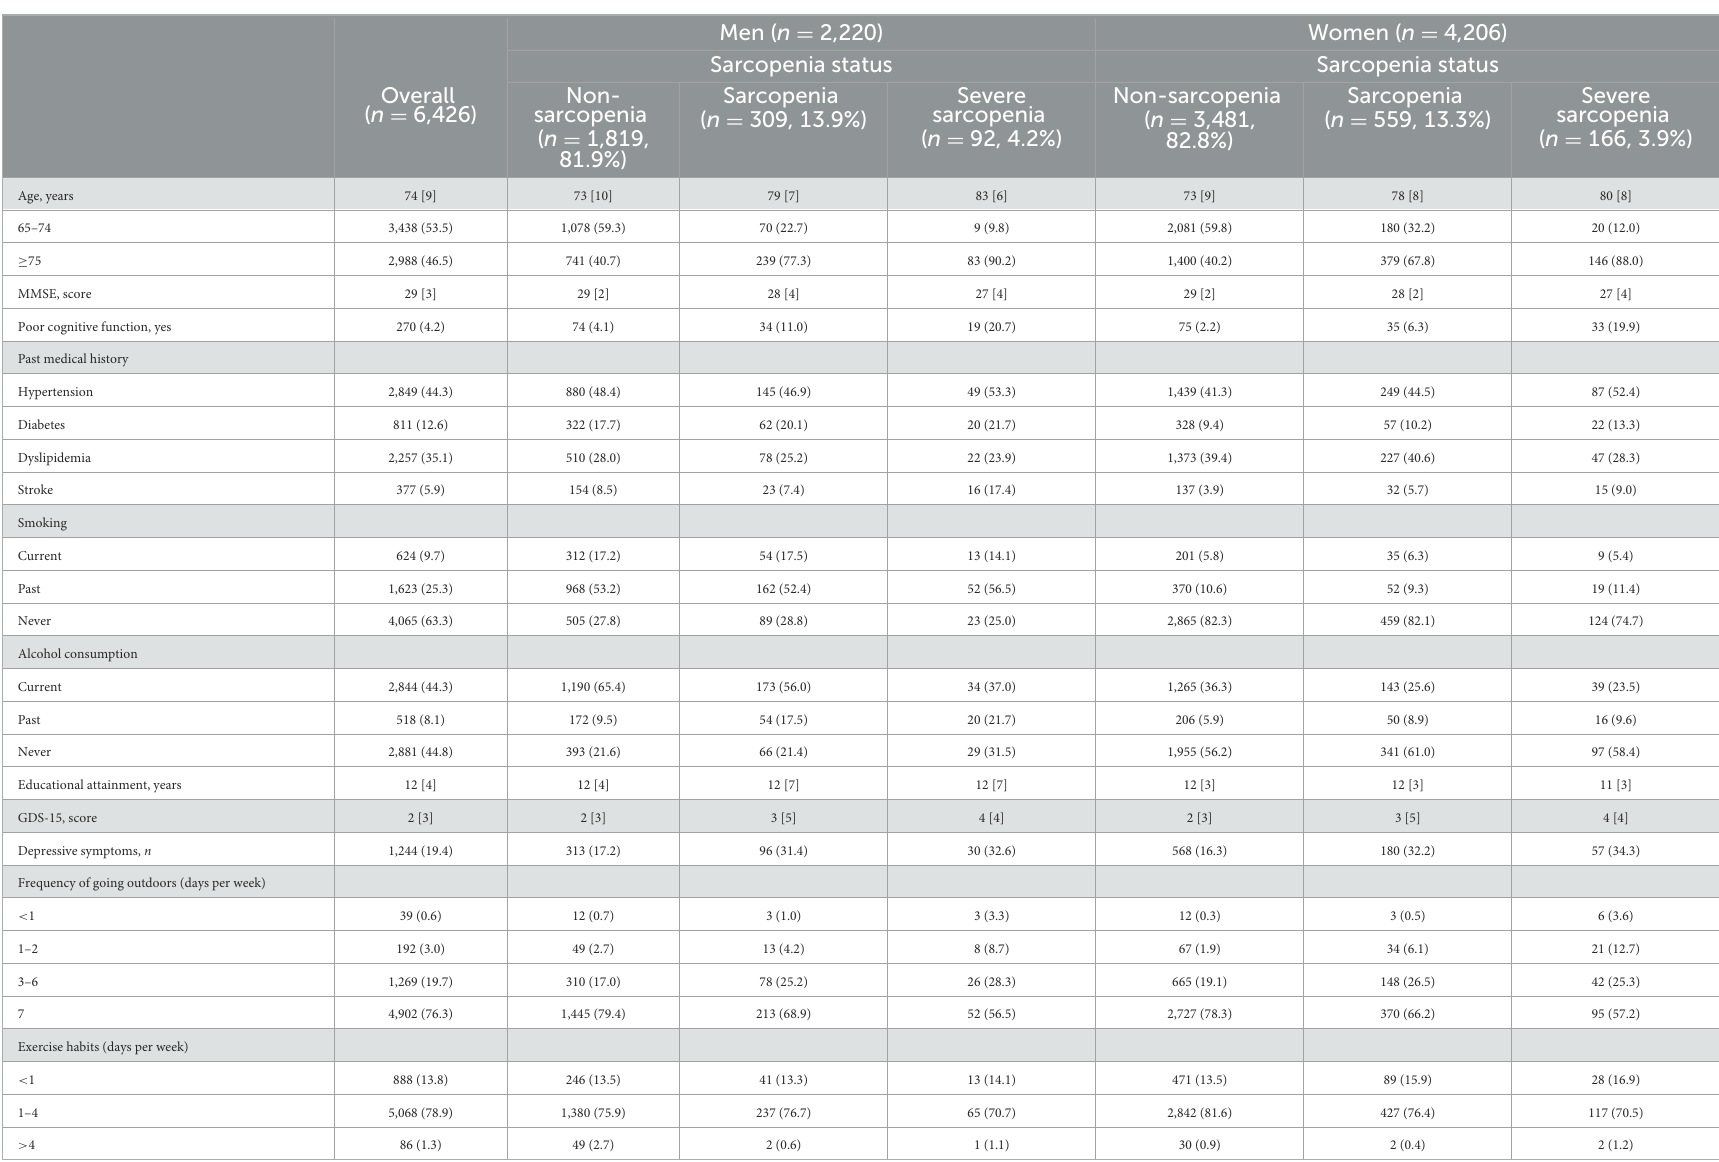
TABLE 1 Characteristics of the cohort according to the severity of